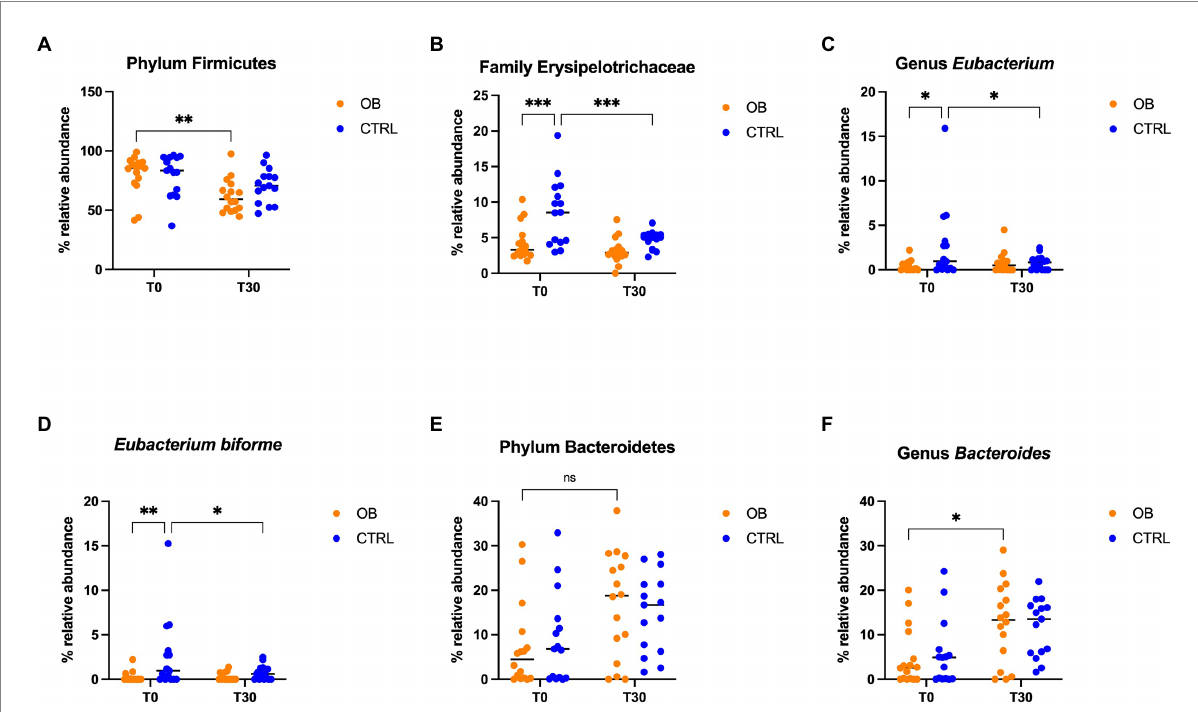
FIGURE 3 Relative abundance of selective bacterial populations: (A) phylum Firmicutes, (B) family Erysipelotrichaceae, (C) genus Eubacterium , (D) species Eubacterium biforme , (E) phylum Bacteroidetes, (F) genus Bacteroides, in fecal samples of obese and lean dogs before (T0) and after (T30) dietary treatment. Significance level: * q < 0.05, ** q < 0.01, *** q < 0.001, ns indicate p -values that did not pass FDR correction ( q = 0.08, p <